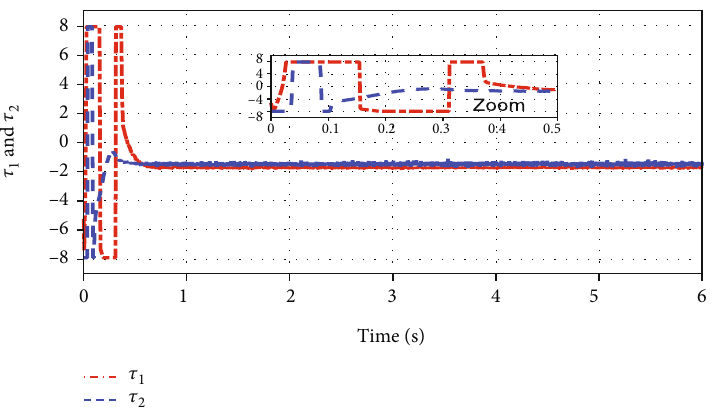
and b σ responses with Case 2. 1 2